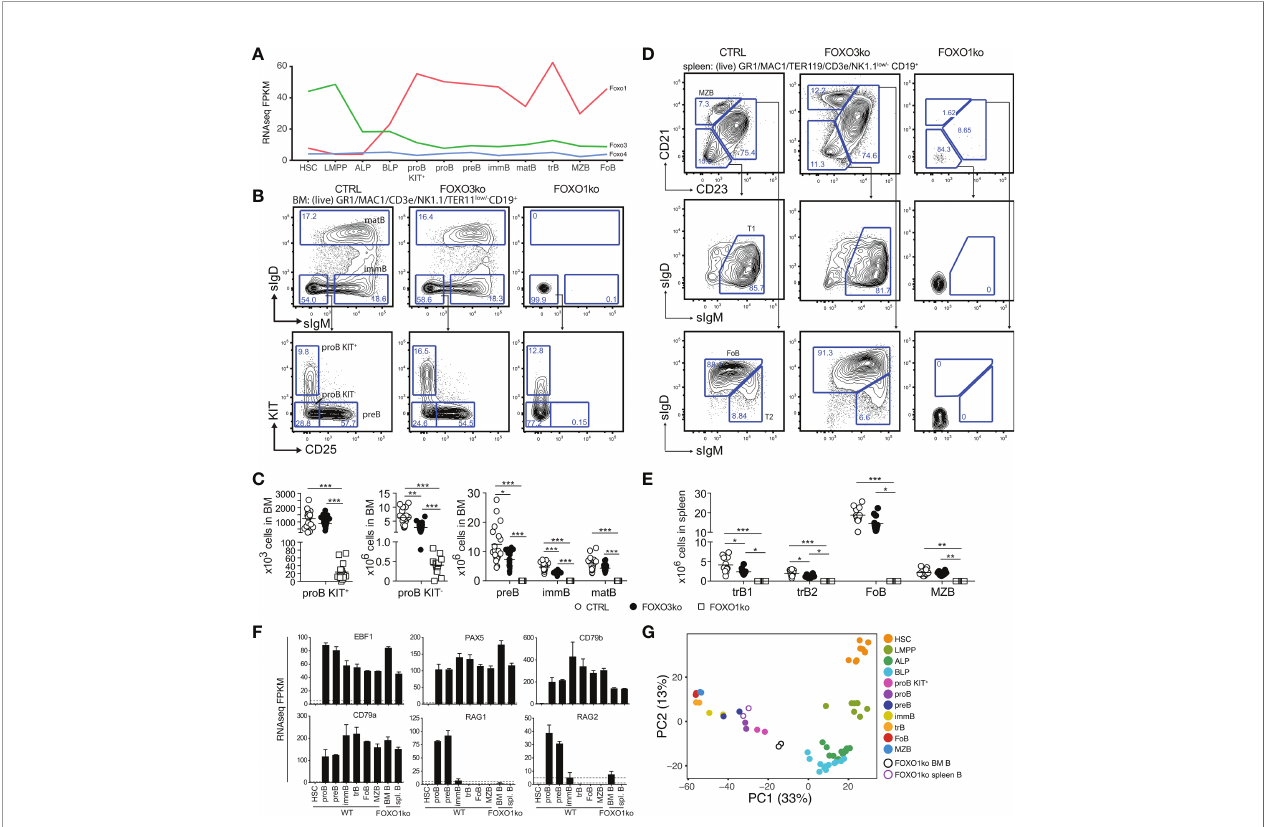
FIGURE 1 | Loss of FOXO1 or FOXO3 impairs B cell development. (A) Gene expression (FPKM) of Foxo1 , Foxo3 , and Foxo4 . HSC, hematopoietic stem cell; LMPP, lymphoid primed multipotent progenitor; ALP, LY6D - common lymphoid progenitor; BLP, LY6D + common lymphoid progenitors; BLP, LY6D+ common lymphoid progenitors; immB, immature B; matB, mature B in BM; trB, transitional B; FoB, follicular B; MZB, marginal zone B. (B) Gating strategy for identi fi cation of BM B lineage cells. (C) Total number of B lineage cells in BM. In panels C and E: each dot represents data from an individual mouse; p-values were calculated using the Kruskal Wallis test with Dunn ’ s test of multiple comparisons; *, ** and *** indicating p-values <0.05, <0.01, and <0.001 respectively. (D) Gating strategy for identi fi cation of spleen B lineage cells. (E) Total number of B lineage cells in spleen. (F) Expression of indicated genes. (G) Principal component analysis of RNAseq